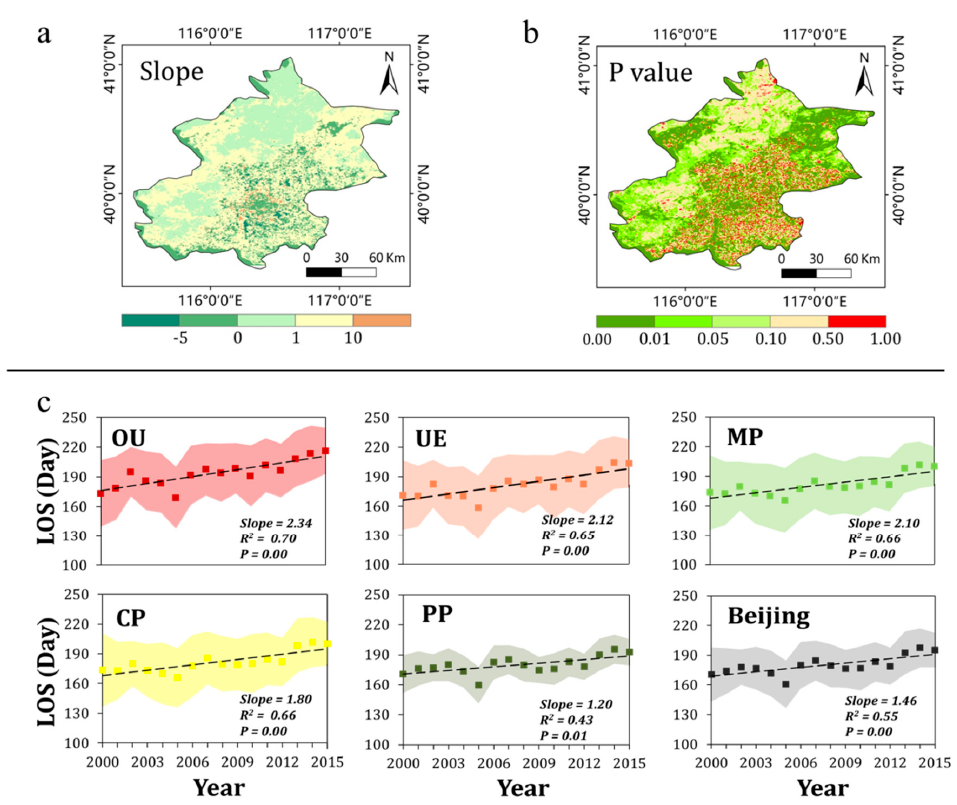
Figure 7. Spatial pattern and temporal changes of length of season (LOS) in Beijing. a and b are the spatial patterns of annual trend and significant test (P value); c is the annual changes with standard deviations (shadow zones with different colors) of various land cover types for LOS from 2000 to 2015.